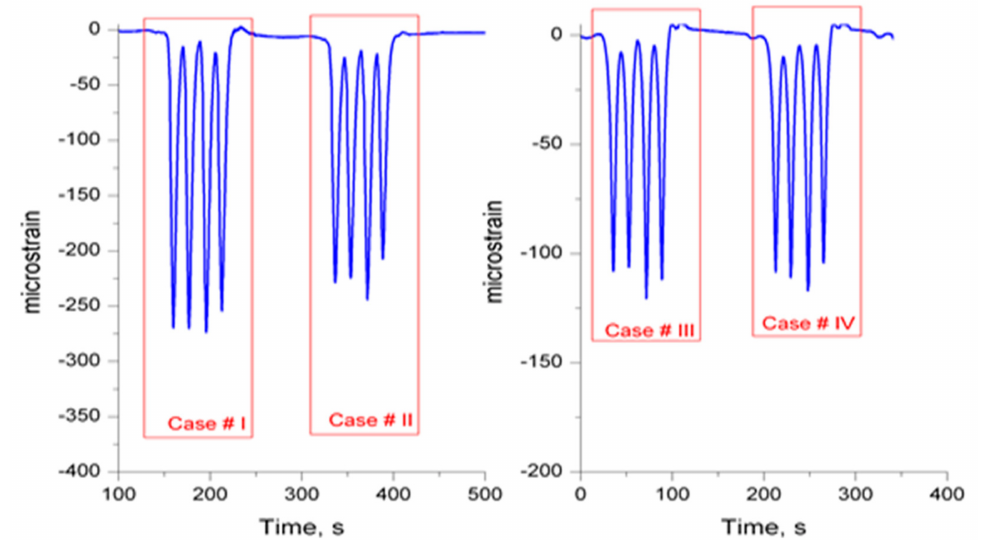
Figure 12. Examples of strain distribution in the vertical direction in the ring girder of one of the tested bucket-wheel excavators. Cases #I to #IV are the so-called proper cases of quasi-uniform distribution.